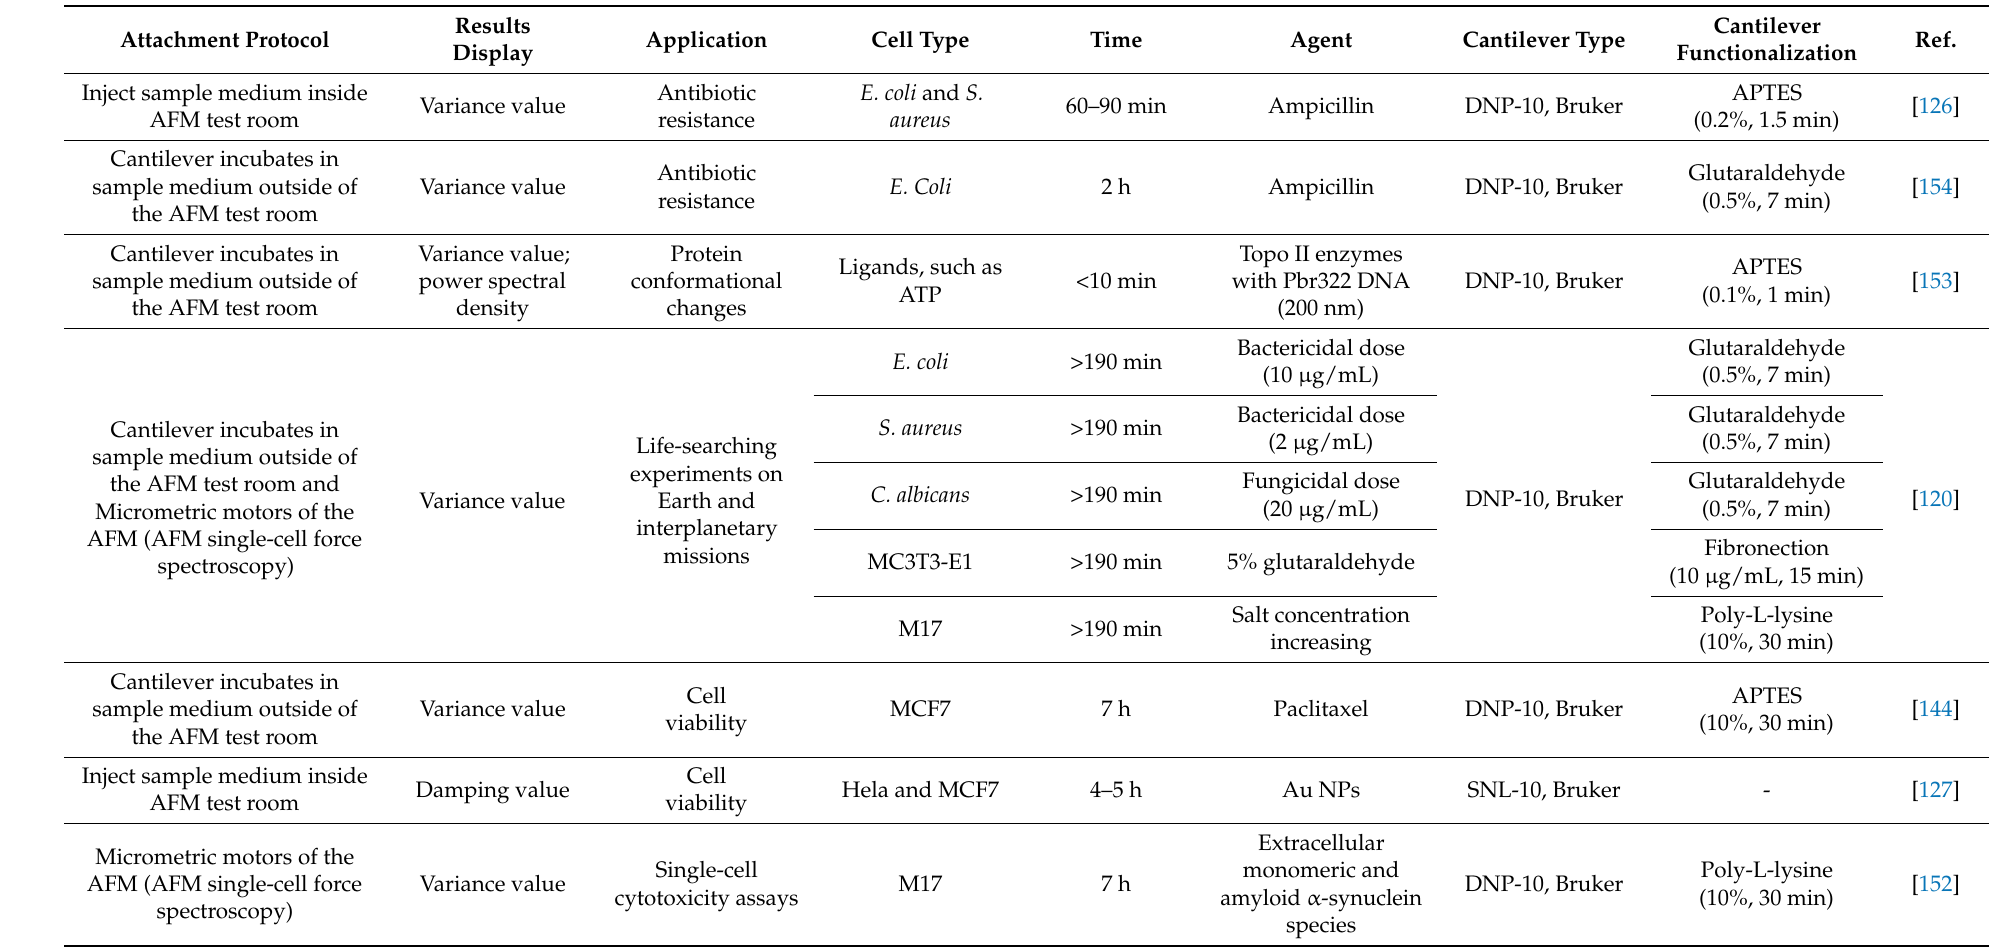
Table 1. Literature survey of AFM nonomotion viability measurement